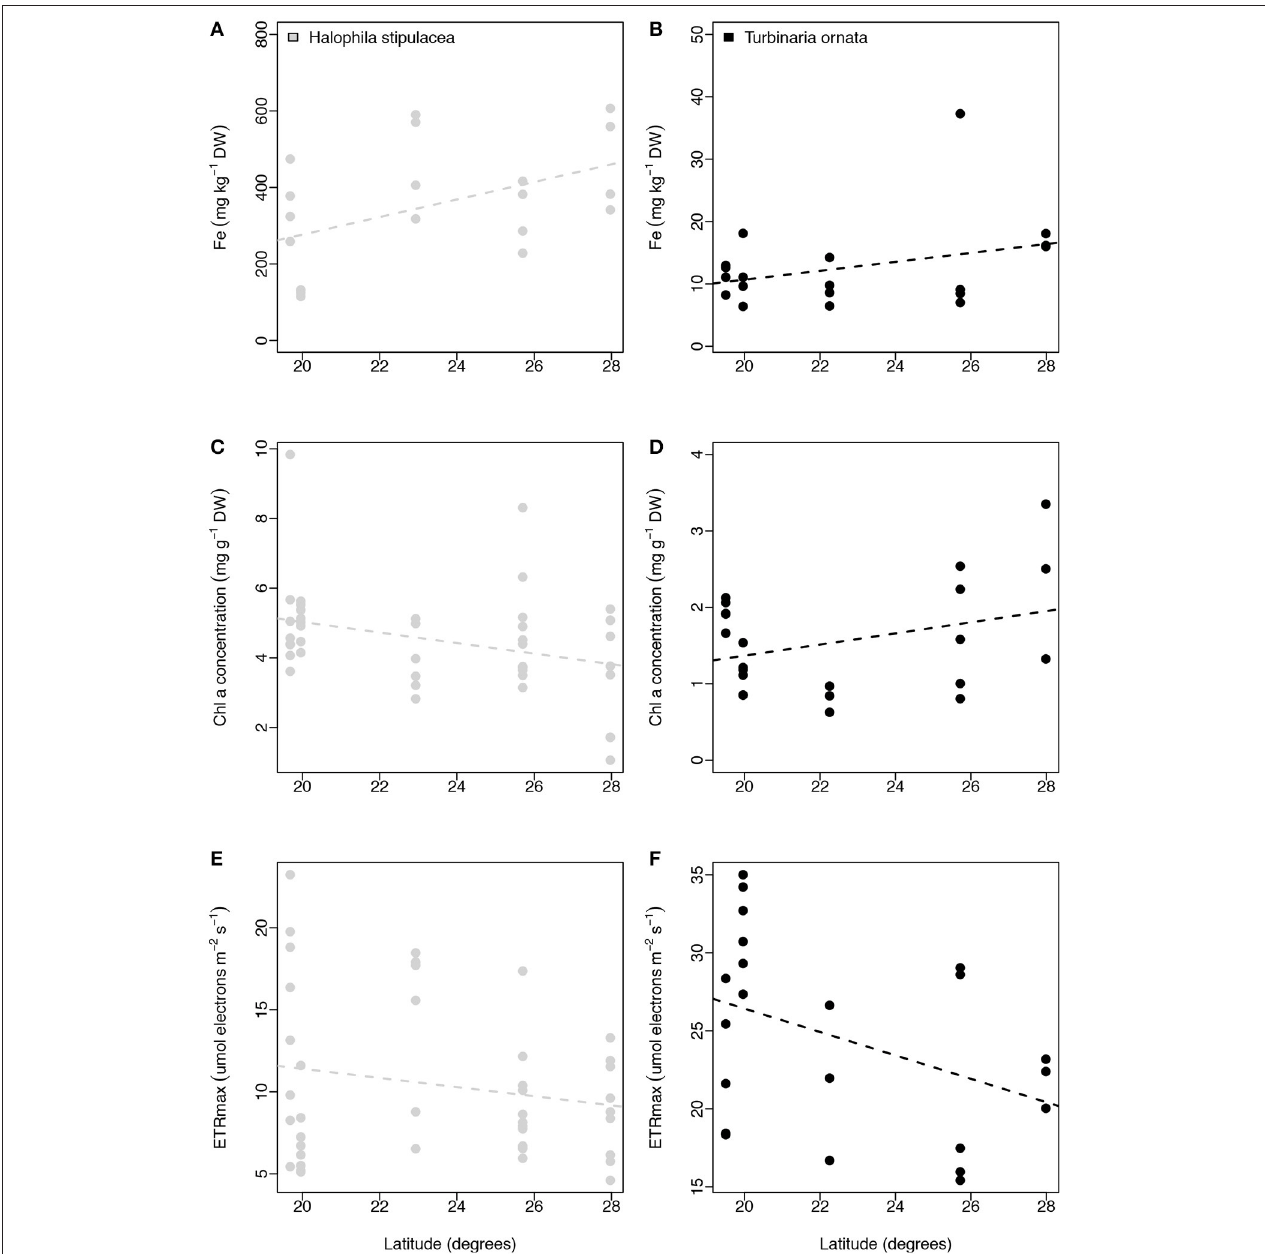
FIGURE 7 | Relationships between latitude (degrees) and iron concentration (mg kg − 1 DW, A,B ), chl a concentration (mg g − 1 DW, C,D ), and ETRmax ( µ mol electrons m − 2 s − 1 ; E,F ) for Halophila stipulacea (depicted with gray dots) and Turbinaria ornata (represented with black dots). Non-significant regressions are indicated with a dash line. The number of replicates is indicated in Table 2